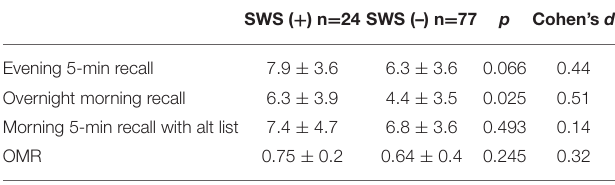
TABLE 3 | Comparison in list-learning scores between 24 participants with and 78 without any